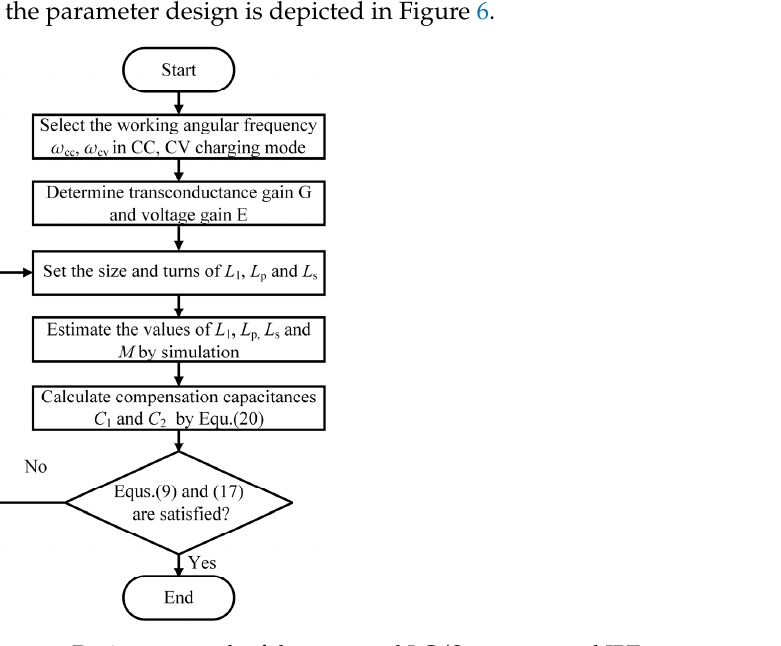
Figure 6. Design approach of the proposed LC/S compensated IPT system.